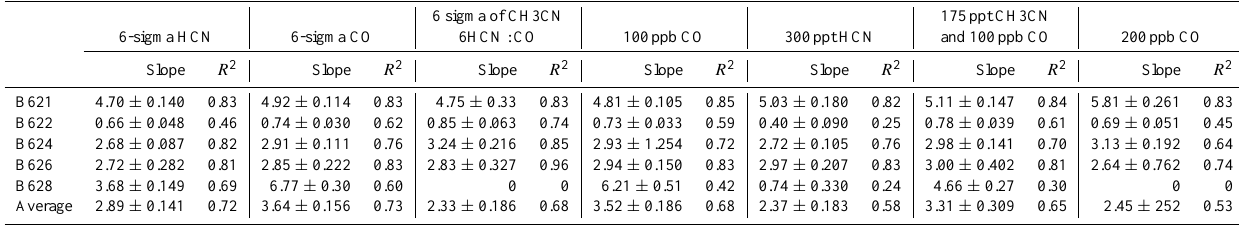
Table 3. The HCN:CO NEMRs (in pptvppbv − 1 ) with R 2 of slope for 5 flights during BORTAS campaign calculated using varying methods previously described in literature.